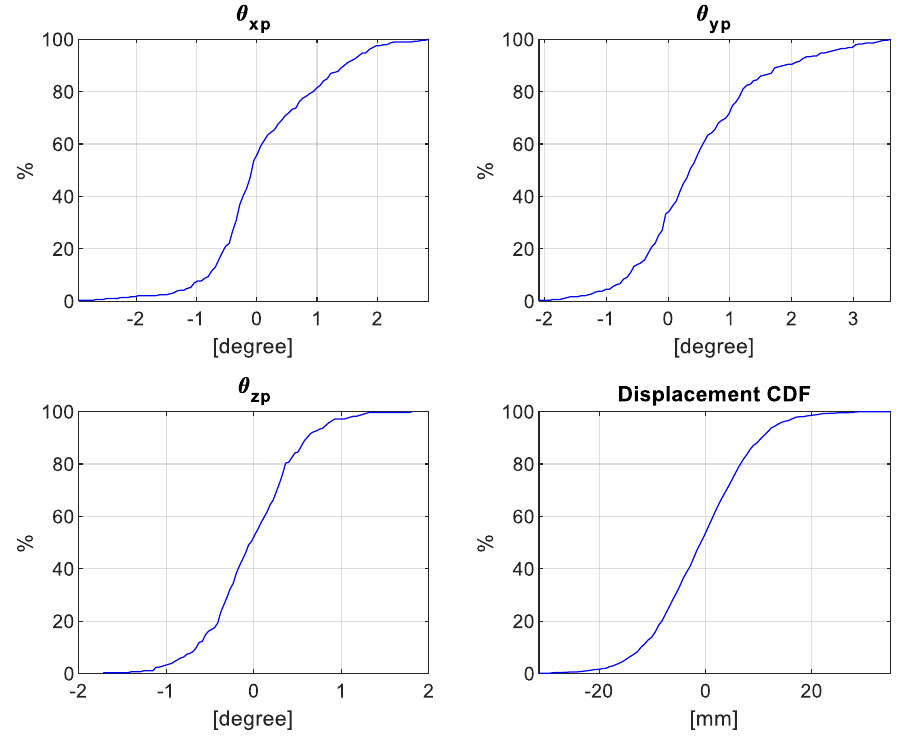
Figure 30. Cumulative Distribution Functions (CDF) for the MLS-based panel 3D orientation and panel-to-panel displacement at Site-2.